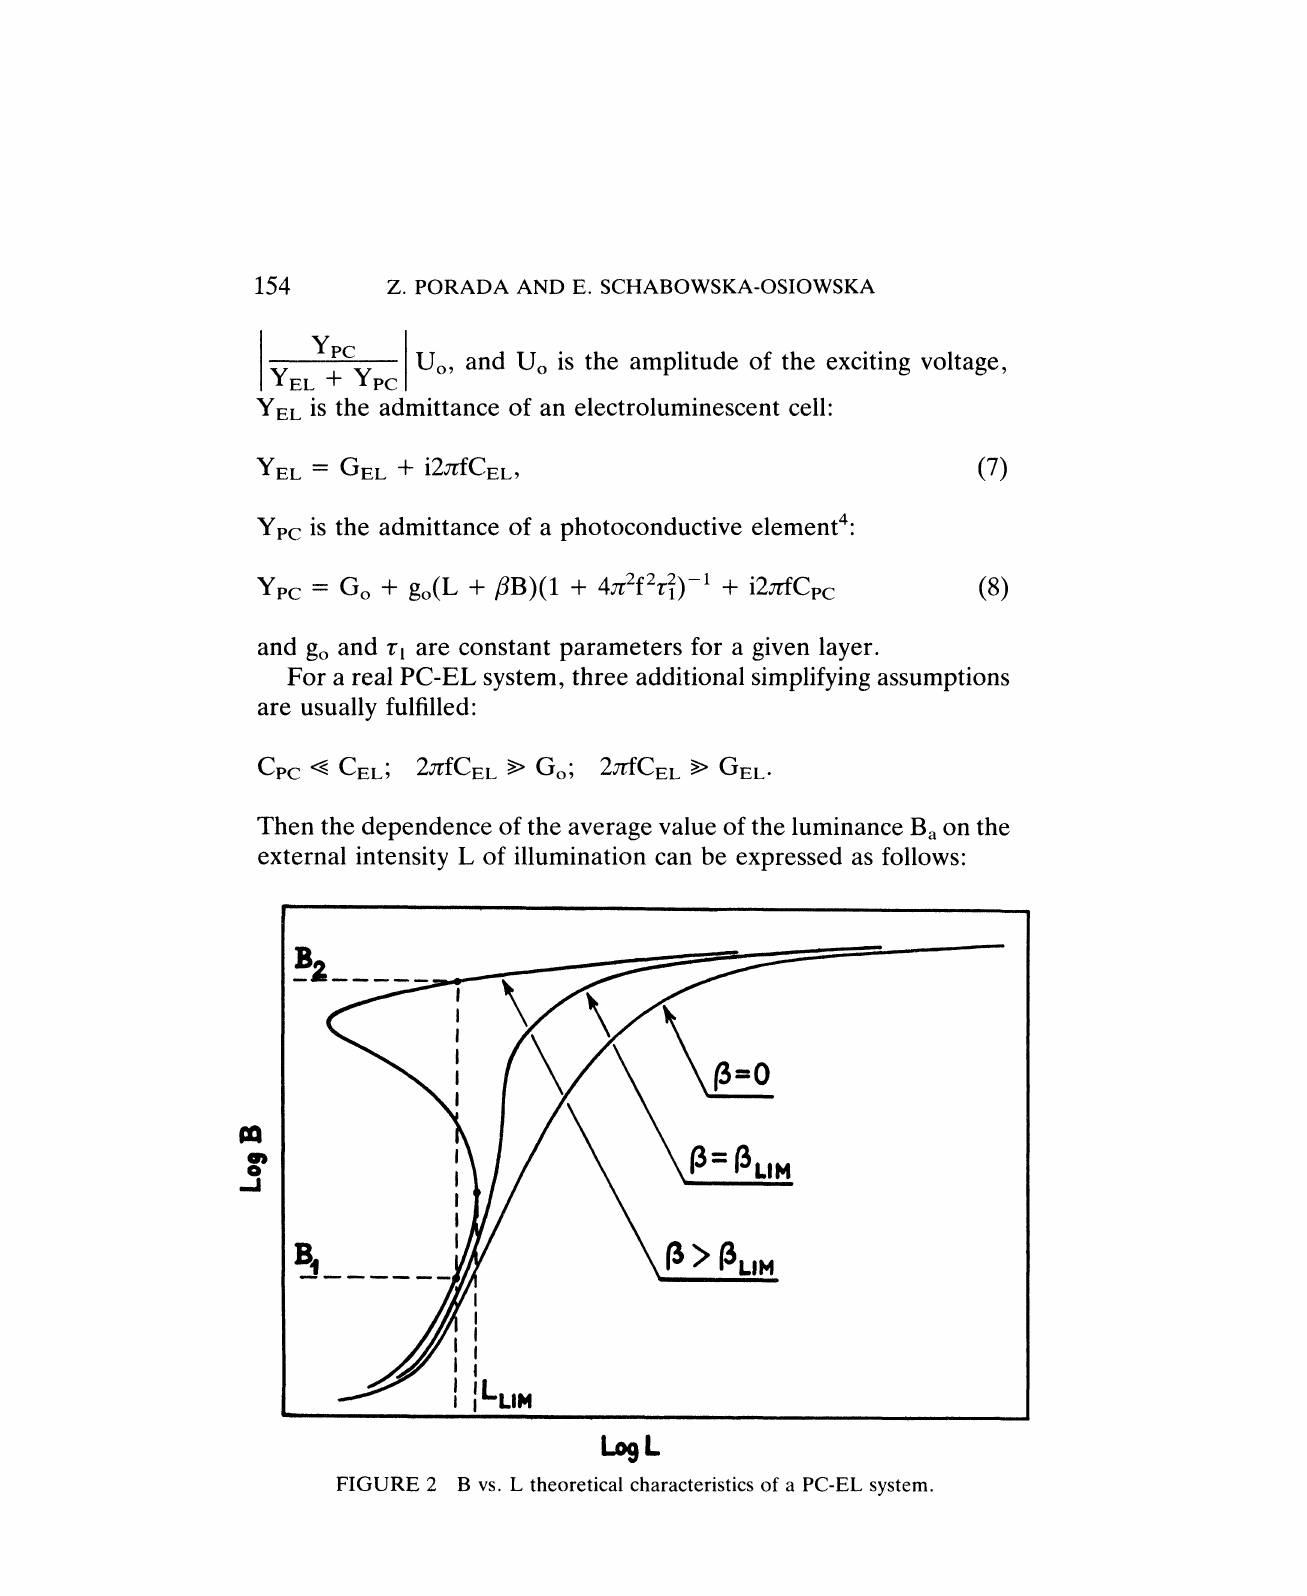
FIGURE 2 B vs. L theoretical characteristics of a PC-EL